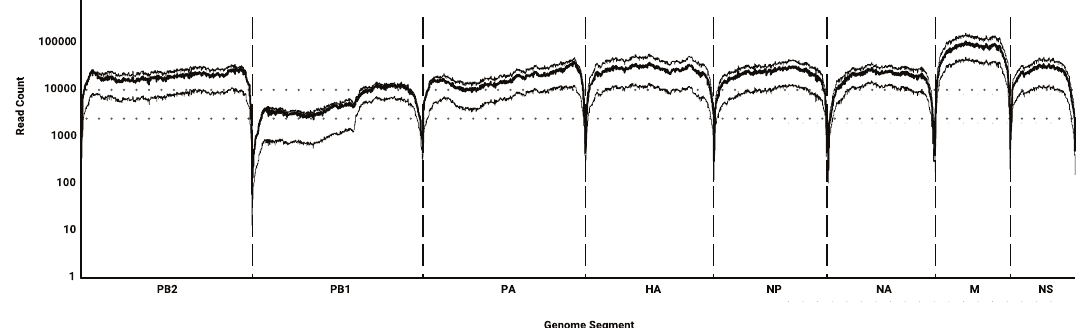
Figure 1. Segment coverage of A(H3N2) influenza virus genomes. Mean depth line for each segment is framed by thinner lines corresponding to the first and third quartiles of depth of coverage. Minimal depth thresholds for 5% (2000X) and 1% (10,000X) variant calling are represented by dot lines.